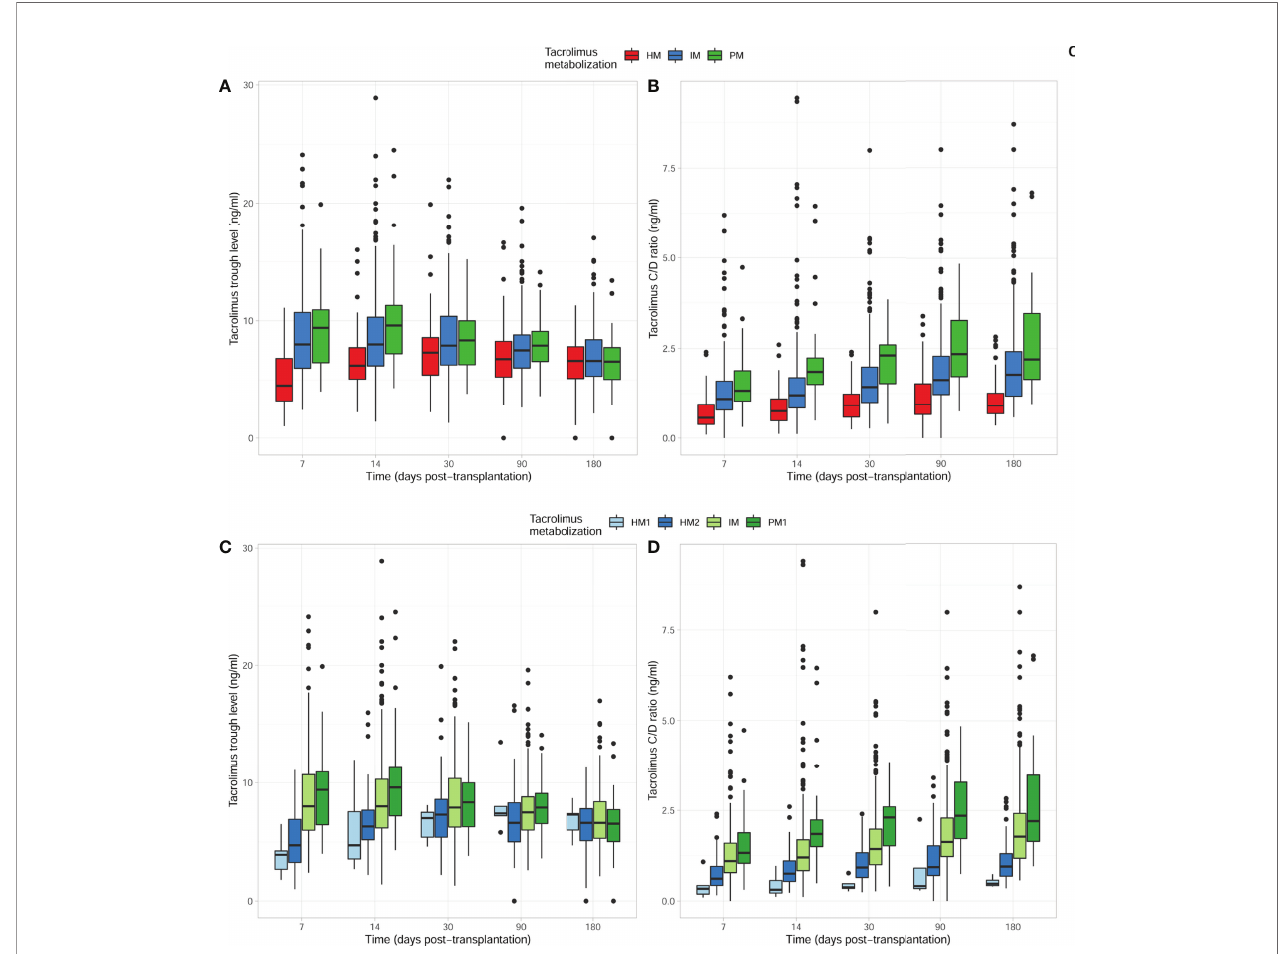
FIGURE 2 | Comparisonoftacrolimusoutcomeswithtime, consideringthefour CYP3ATAC-metabolizinggroups. (A) TACtroughlevels betweenHM/IMandPMclusters. Signi fi cantlylower TAClevelswere observedwithinthe fi rst2weeksearlyafter transplantationinHM as comparedto IM andPM patients.TACC 0 values (ng/ml) were4.50 (3.15